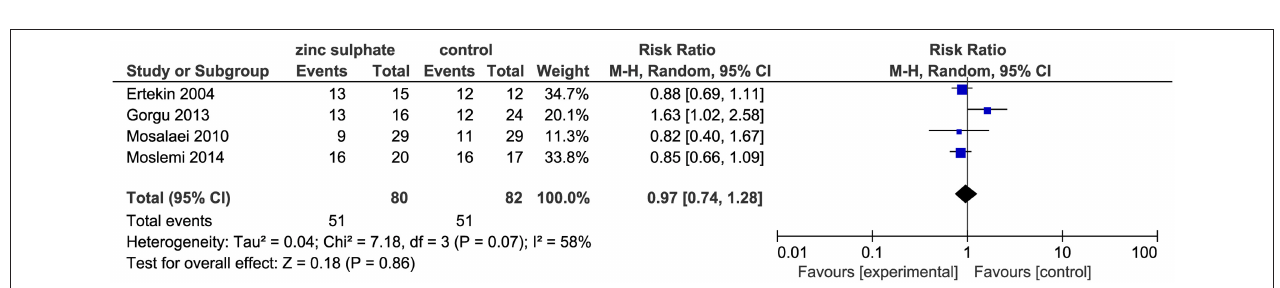
FIGURE 2 | Risk of bias for all eligible studies: (A) risk of bias graph and (B) risk of bias summary.